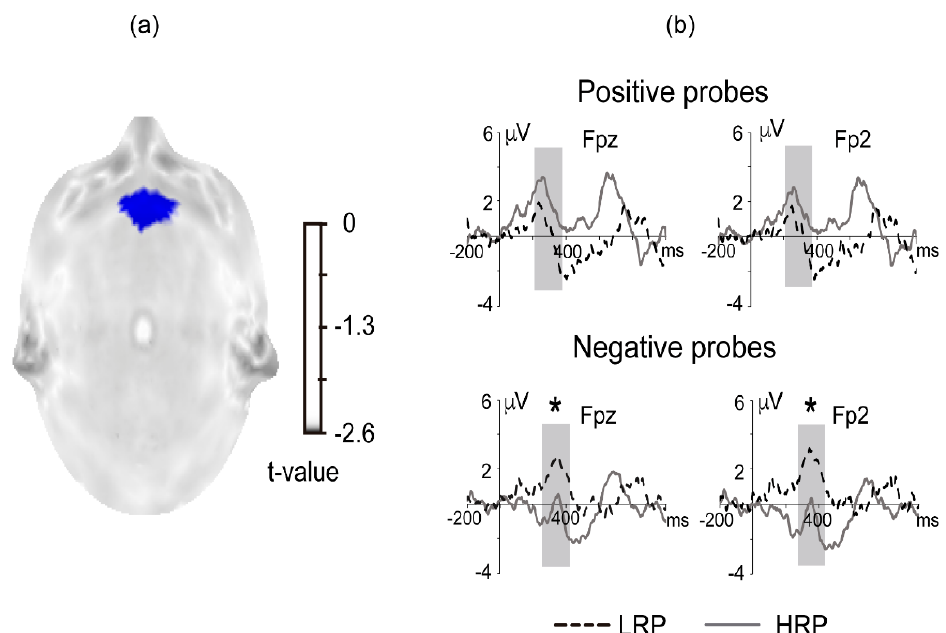
Figure 4. ( a ) Statistical t map of WM-related change of the P300 for the comparison between groups of negative probes. Blue represents t-values, where the P300 amplitude difference (low WM load > high WM load) was significantly smaller. ( b ) Grand average difference waves (low WM load minus high WM load) of the groups per type of probe at Fpz and Fp2. Black solid lines represent the HRP group, and dotted gray lines represent the LRP group. Gray shadow boxes represent the analysis epoch, and the asterisks indicate significant differences between groups; p <